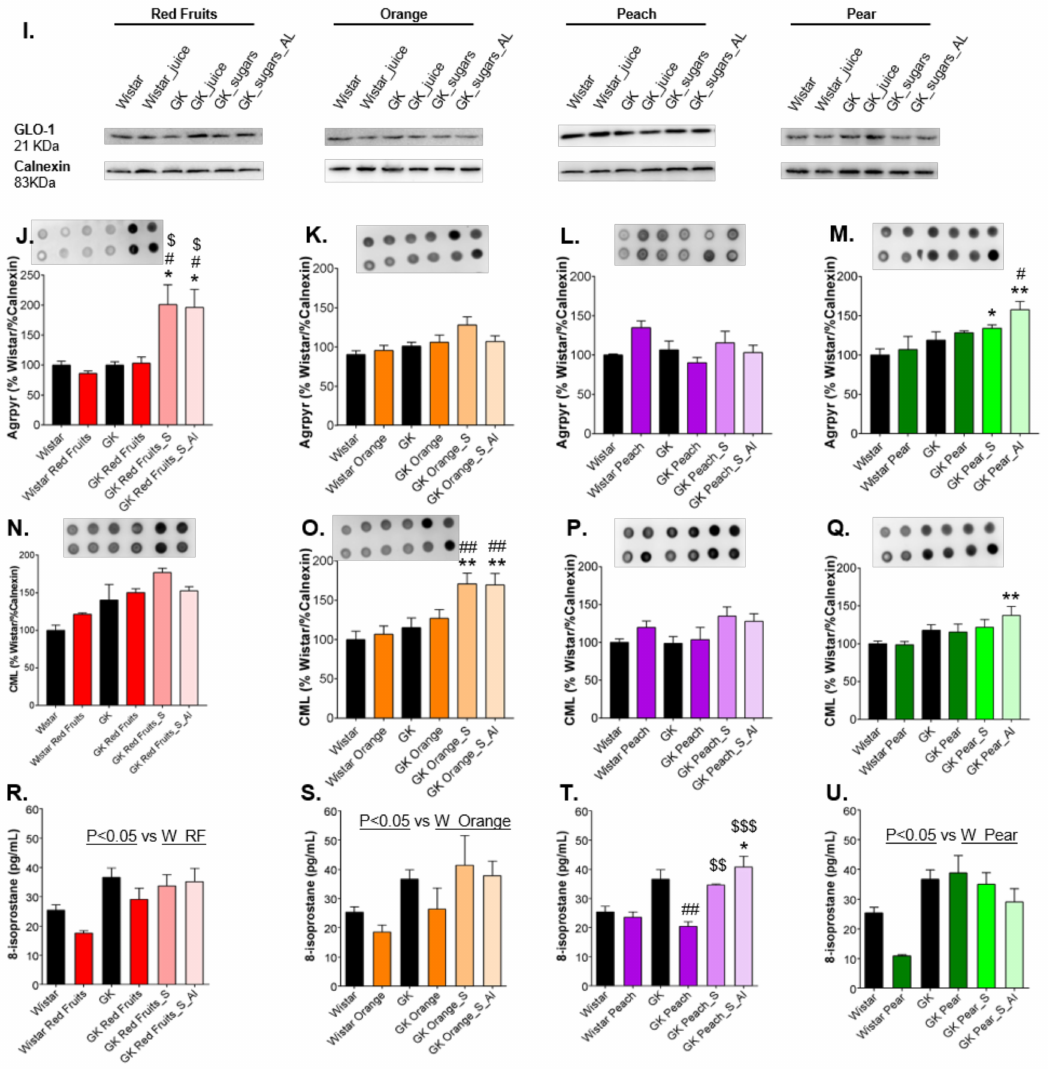
Figure 7. Heart weight was recorded ( A – D ) and the levels of catalase were determined by Western blot ( E – H ). Representative western blot membranes of GLO-1 in the heart are shown in ( I ). Heart CML ( J – M ) and argpyrimidine ( N – Q ) were determined by dot blot. 8-Isoprostane levels were determined as a marker of lipid peroxidation ( R – U ). * different from Wistar; # different from GK; $ different from GK_Juice. 1 symbol, p < 0.05; 2 symbols, p <